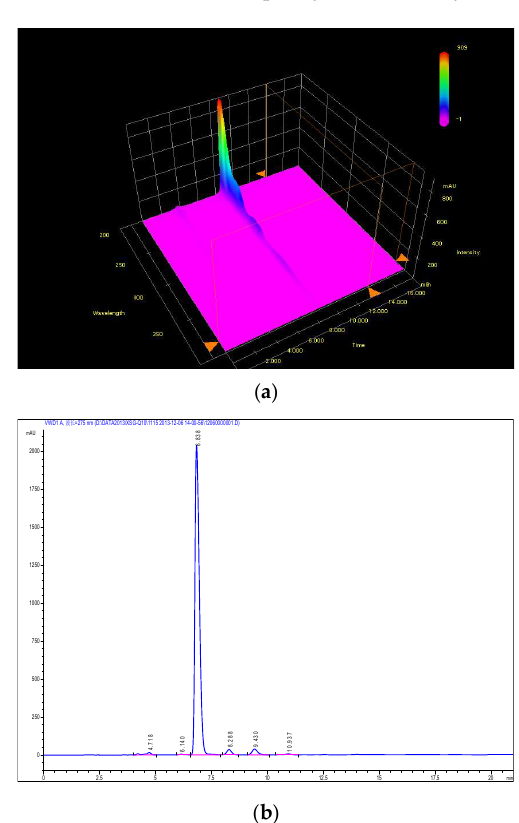
Figure 3. ( a ) Typical chromatograms and 3D maps of reversed-phase system for calculating impurity X content by normalization method; ( b ) Typical chromatogram of normal phase system for calculating impurity X content by normalization method.